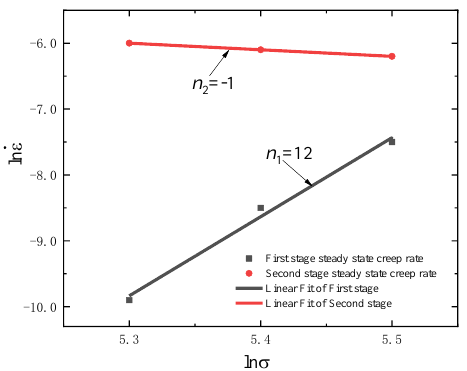
ff erent stress conditions at 153 ◦